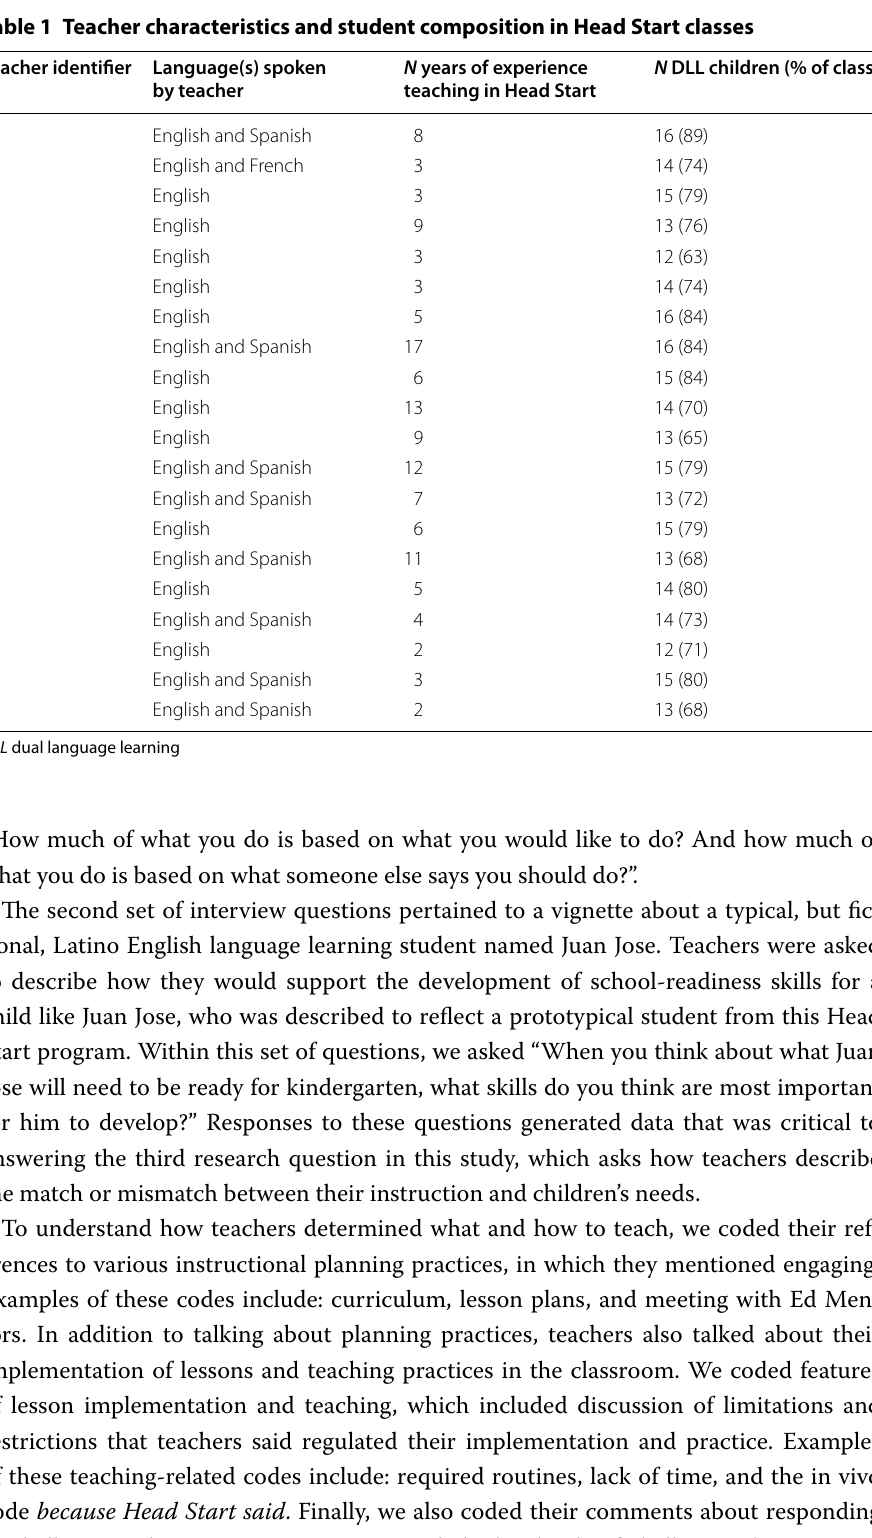
Table 1 Teacher characteristics and student composition in Head Start classes